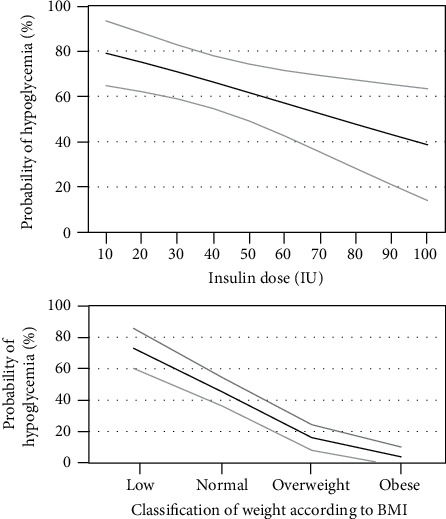
Probability of clinically significant hypoglycemia according to insulin dose and probability of severe hypoglycemia according to body mass index (BMI). The gray lines represent the 95% confidence interval.